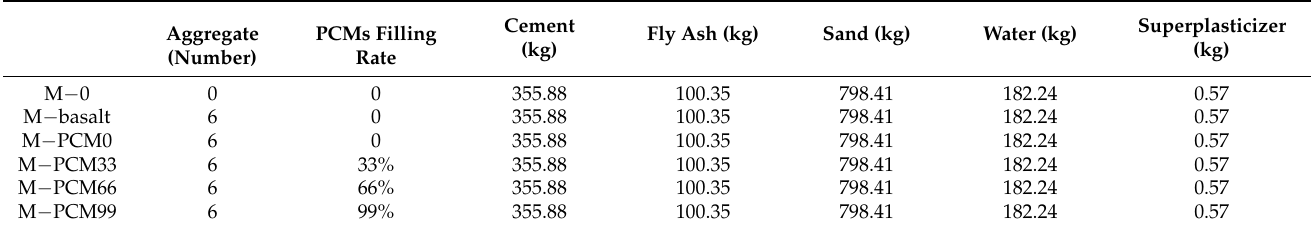
Table 4. Mixture proportions of phase change cementitious composite.